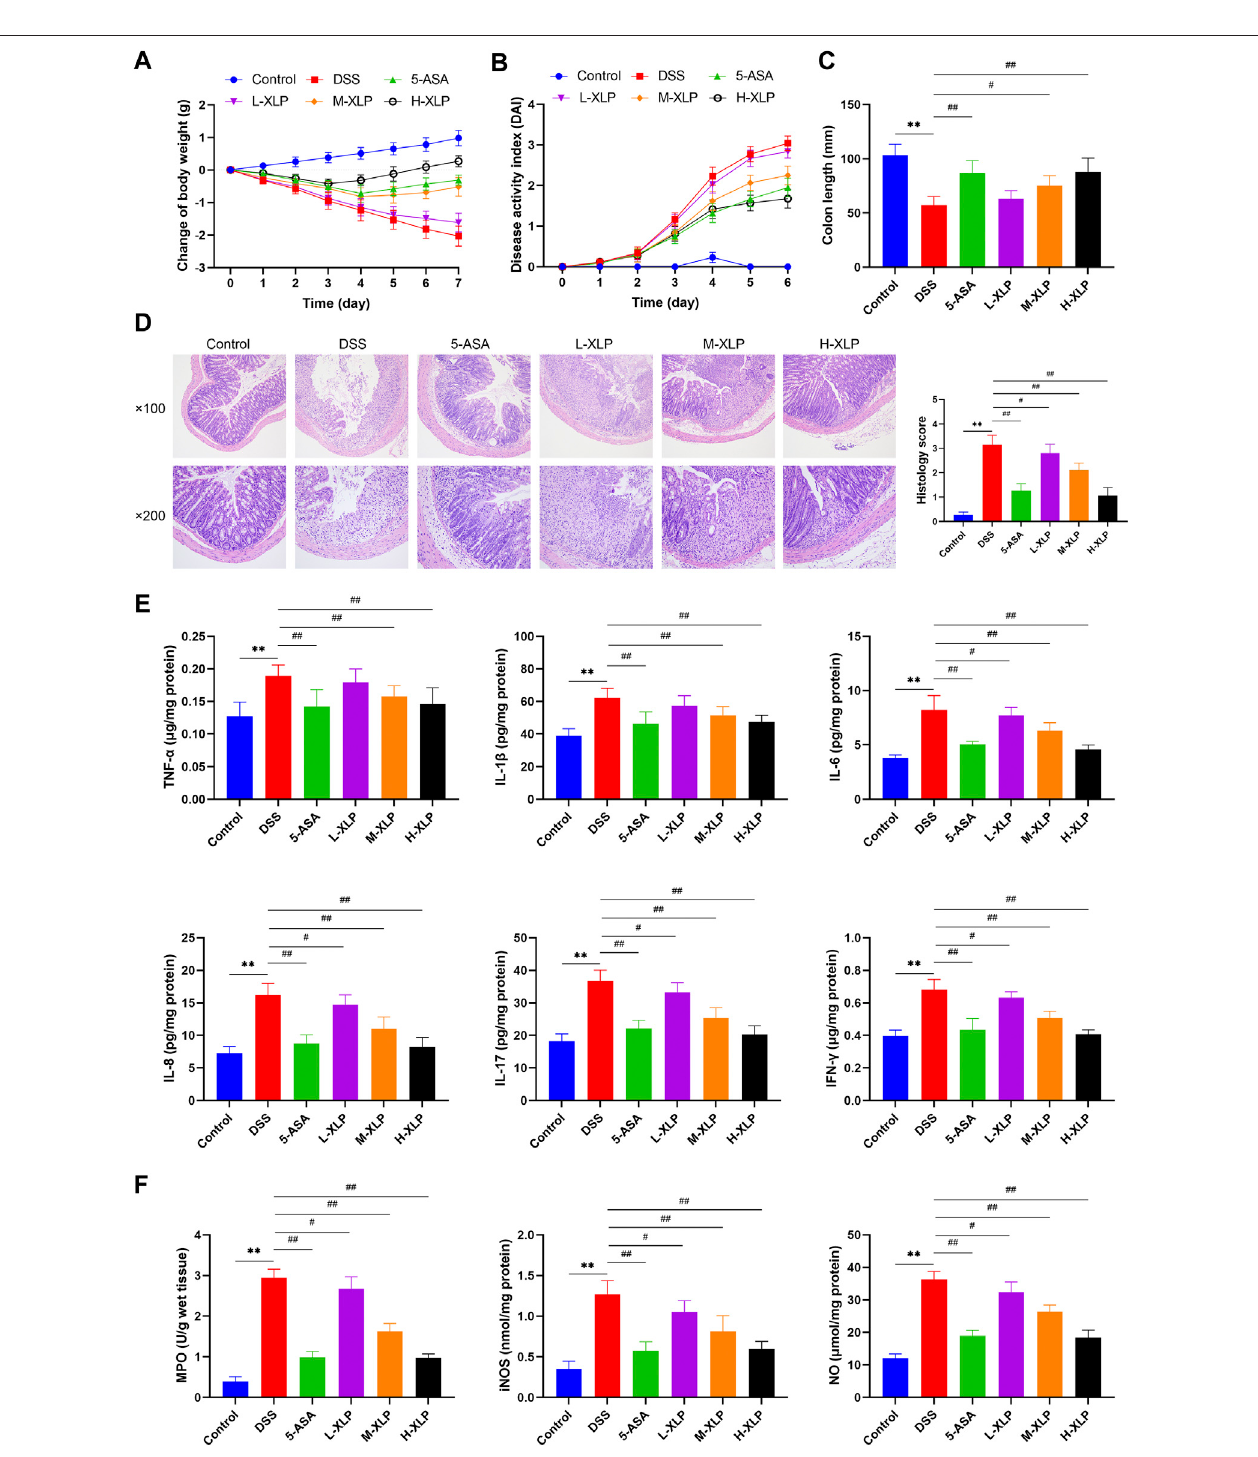
FIGURE 3 | Xianglian pill alleviated DSS-induced acute colitis in mice. (A) Body weight of mice in each group were monitored from day 1 to day 7. (B) Disease activity index of mice in each group were calculated from day 1 to day 7. (C) Mice were sacri fi ced and colonic tissues were collected and measured on day 8. (D) Representativehematoxylinandeosinstainingimagesofcolontissuesfromeachgroupwereperformedandobservedunderamicroscope(upperpanel × 100andlower panel × 200). Histologicalscoresofcolons werecalculated. (E) Thelevels ofTNF- α ,IL-1 β ,IL-6, IL-8, IL-17, andINF- γ in colontissues from mice weremeasuredby enzyme linked immunosorbent assay. (F) Detection of MPO activity and levels of NO and iNOS in colon tissues from mice were measured. * p < 0.05, ** p < 0.01 vs. control group, # p < 0.05, ## p < 0.01 vs. DSS group.